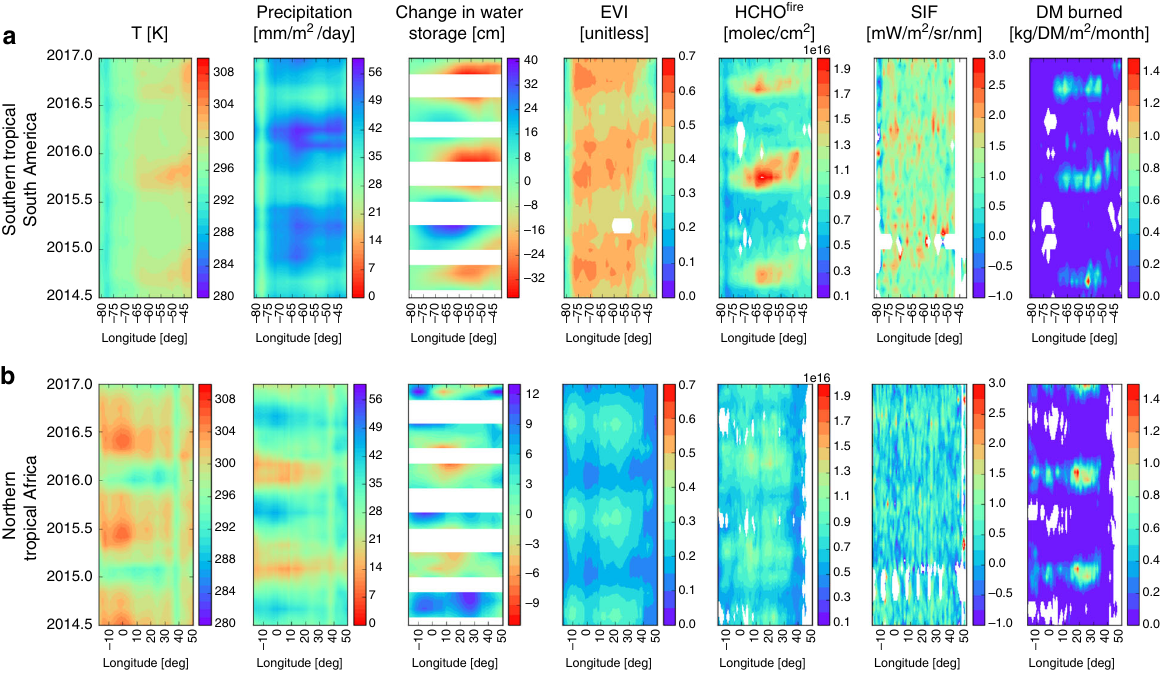
Fig. 4 Correlative data to interpret regional X CO2 data. Correlative data over a southern tropical South America and b northern tropical Africa. The